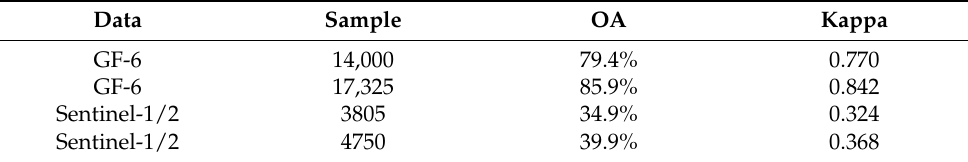
Table 6. Comparison of CNN classification results before and after data